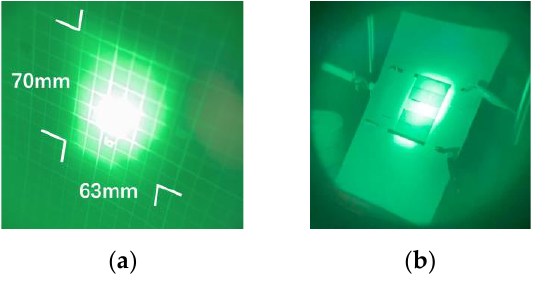
Figure 8. ( a ) Experimental irradiation spot; ( b ) 5-series solar cell with 40° rotation.